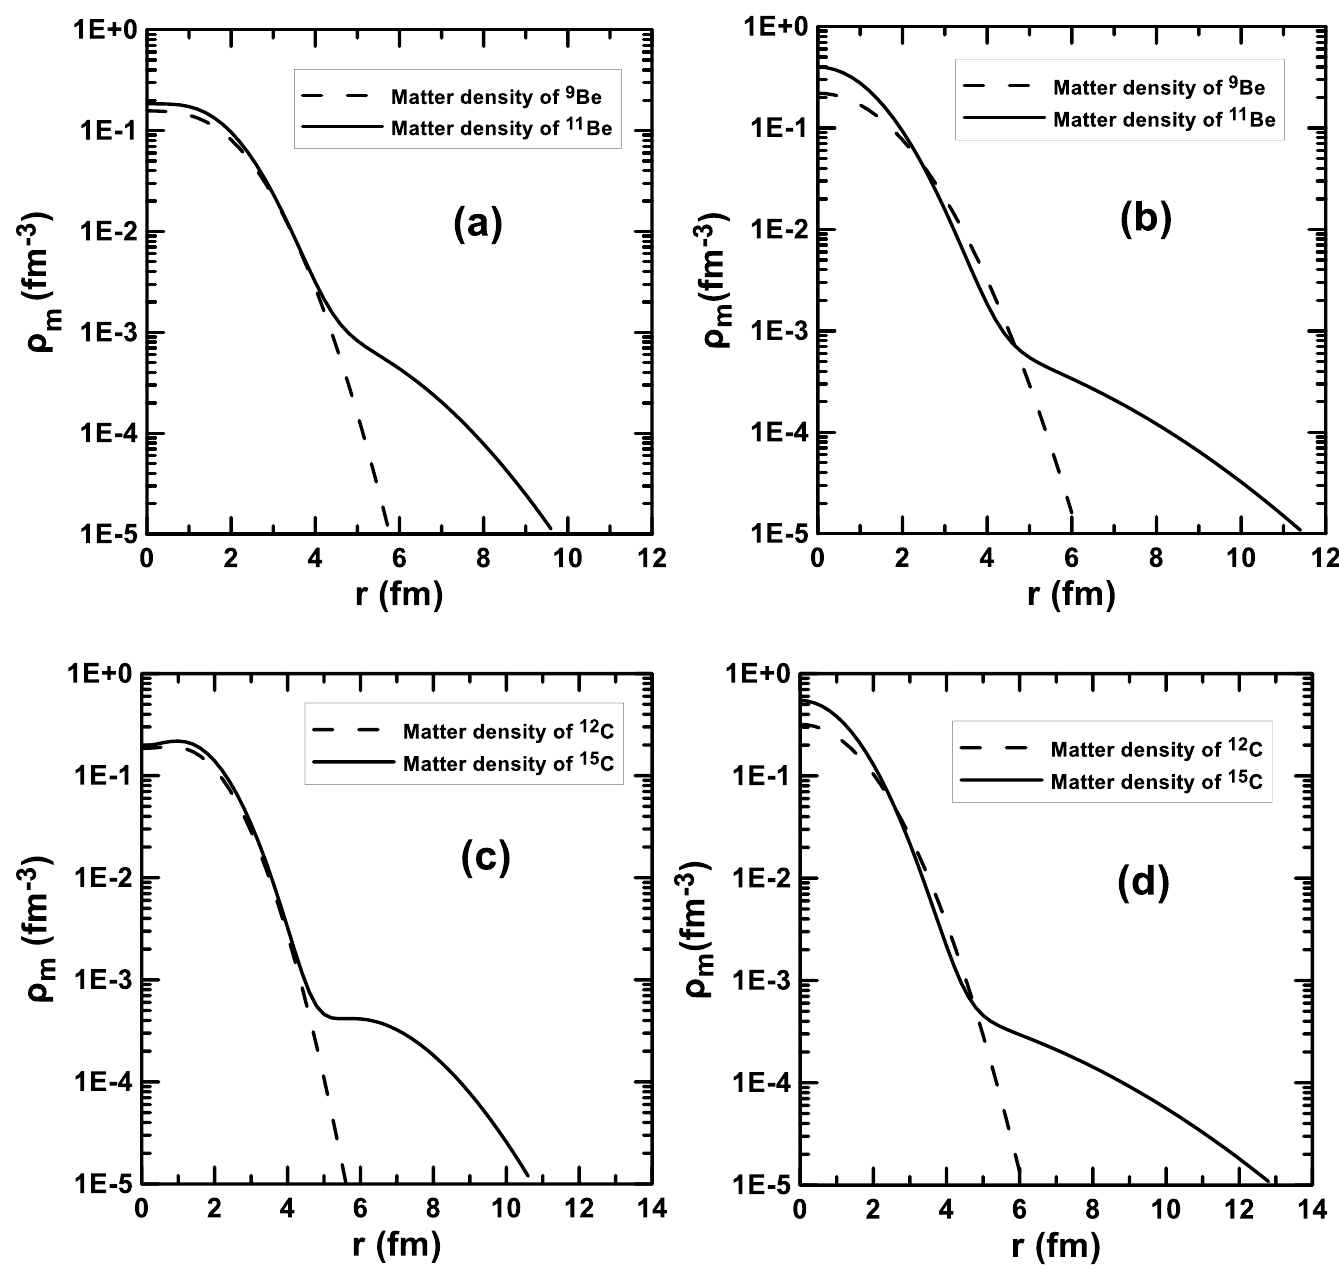
Fig.4: The comparison between the calculated matter density of unstable and stable nuclei. The left and right columns correspond to the calculations of TFSM and BCM, respectively. The top and bottom panels correspond to ( , 9 Be Be 11 ) and ( C 12 , C 15 ) ,